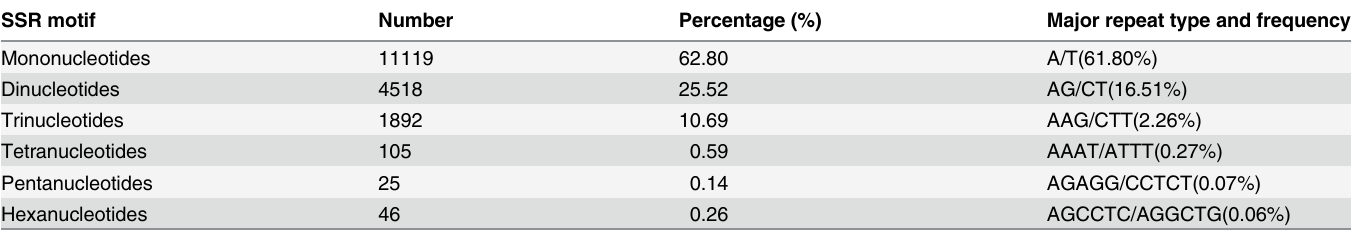
Table 7. General statistics of repeat type of SSR motif from ‘ Hangbaishao ’ transcriptome